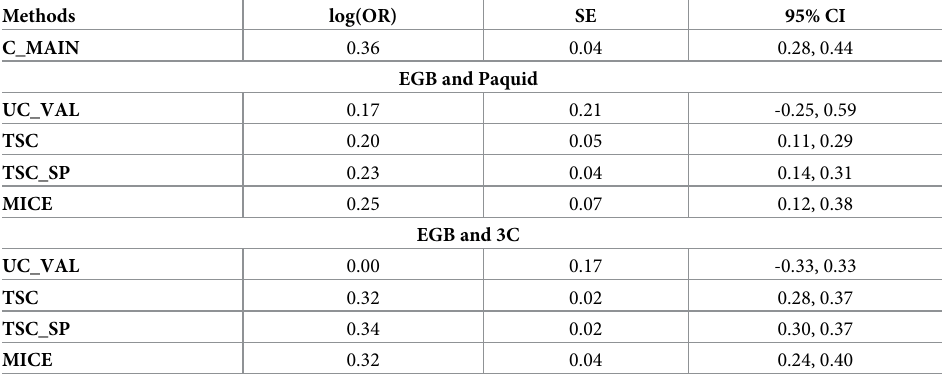
Table 2. Estimates of exposure effect (log-odds ratio) of association between BZD and fractures; EGB database (n = 60,243, 2006–2009) and Paquid (n = 1,342, 1993–1997) and 3C (n = 2,231, 2003–2007) cohorts in France.